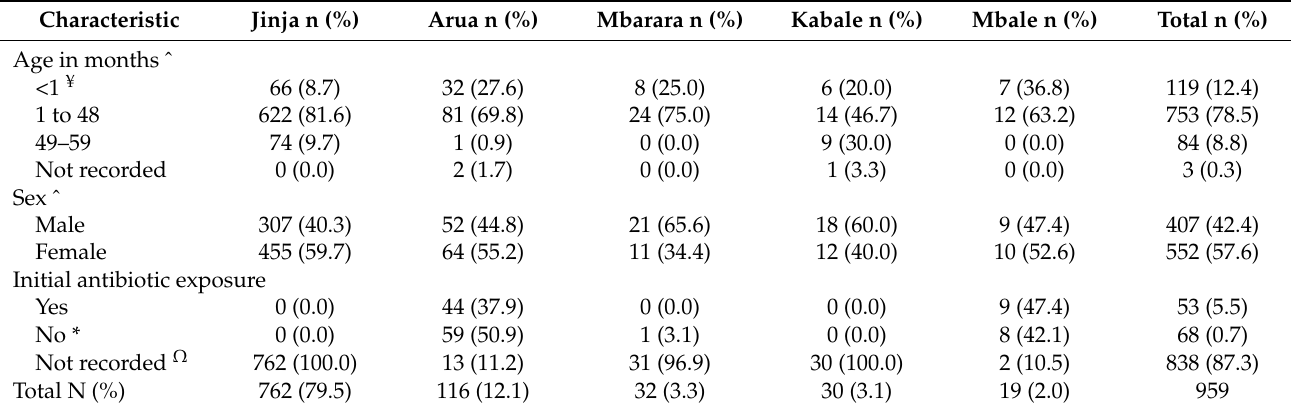
Table 2. Demographic and clinical characteristics of hospitalized non-malarial febrile children undergoing blood culture at five antimicrobial resistance surveillance sites in Uganda, October 2017–September 2018.